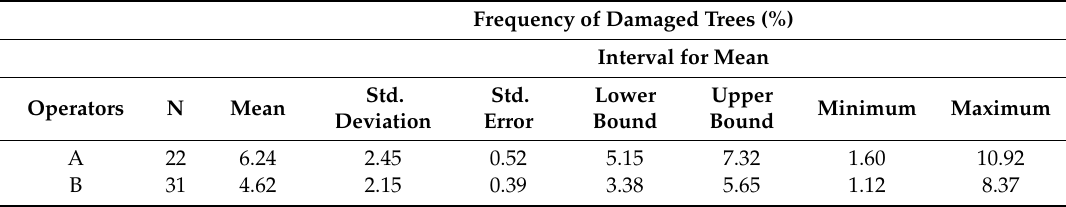
Table 2. Frequency of damaged trees with respect to operator.